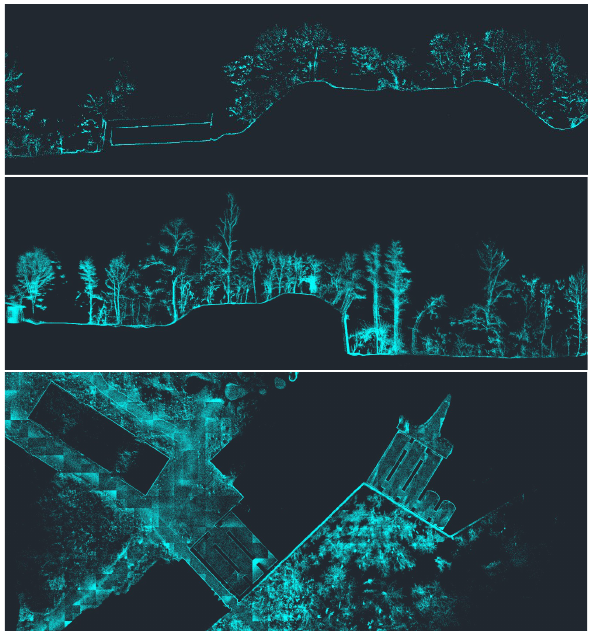
Figure 8. Cross-section of the registered point cloud (top and center) and plan view (bottom).